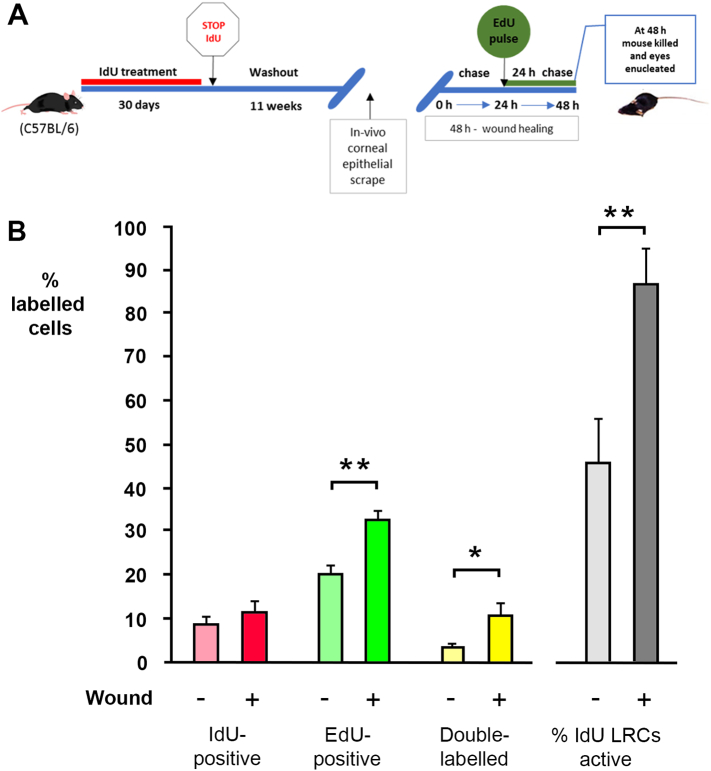
Activity of label-retaining cells in limbal epithelia 24–48 h after corneal wounding in adult mice. (A) Schematic representation of a pulse-chase-pulse experimental design illustrating the exposure of 8 weeks old C57BL/6 mice to 30 days IdU treatment, 11-weeks washout and EdU pulse 24 h after unilateral corneal epithelial wounding with mice death at 48 h. (B) Cell proliferation in the limbal epithelia of unwounded (n = 12) and wounded (n = 12) corneas. Data are expressed as mean (%) ± SEM. The mean percentage of EdU-labelled cells increased significantly in wounded corneas compared to unwounded (P < 0.05 (**), t-test, n = 12). There was also a significant increase in the number of double-labelled cells (P < 0.05 (*), t-test, n = 12) both in absolute terms and as a proportion of the total number of label-retaining cells 48 h after wounding.